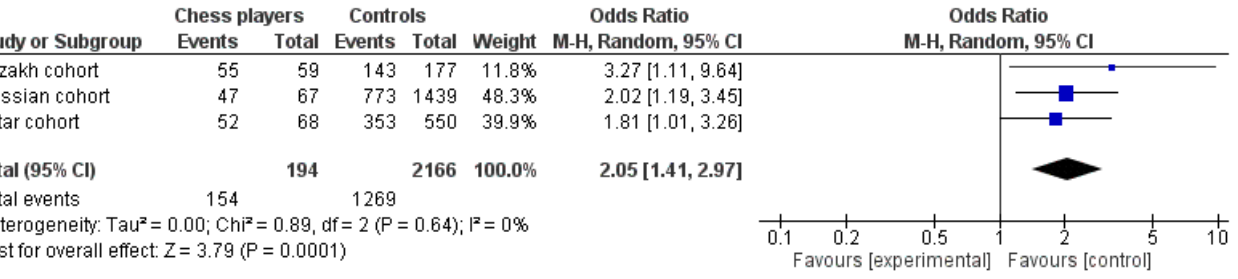
Figure 2. Meta-analysis for association studies for the KIBRA gene and chess player status. The prevalence of the rs17070145 CT/TT genotypes has been shown in chess players. The purple squares represent the ratio of CT/TT genotypes in chess players for each individual study. The black diamond represents the pooled ratio of CT/TT genotypes in all chess players and its 95% CI.